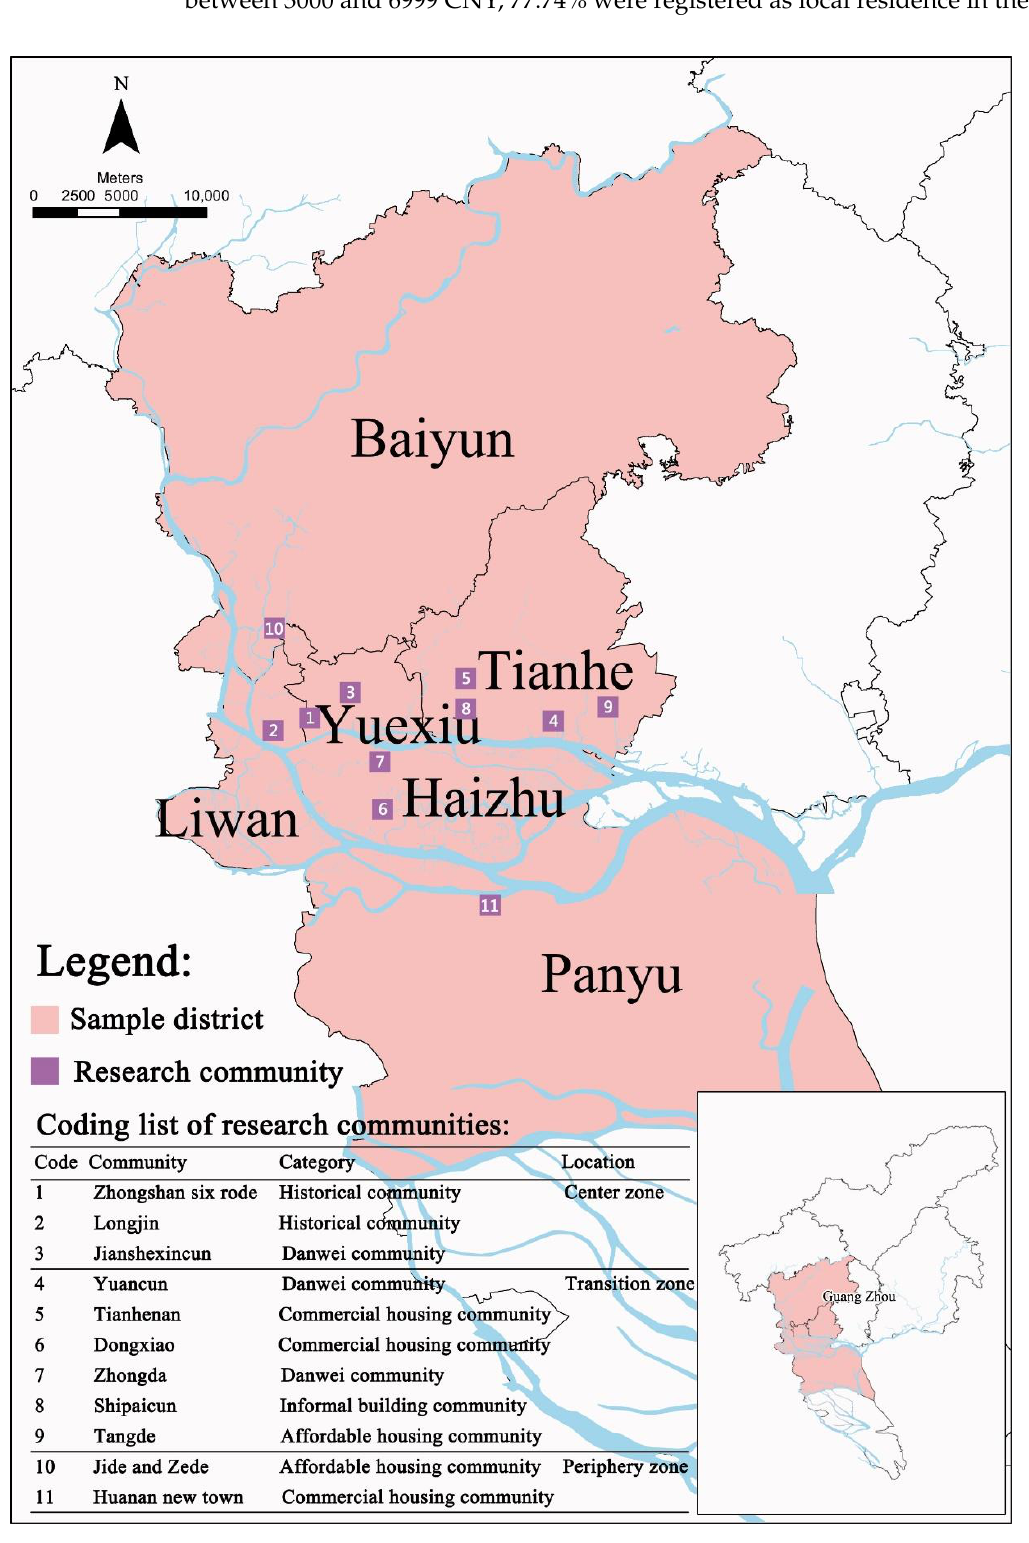
Figure 1. Distribution of research communities.